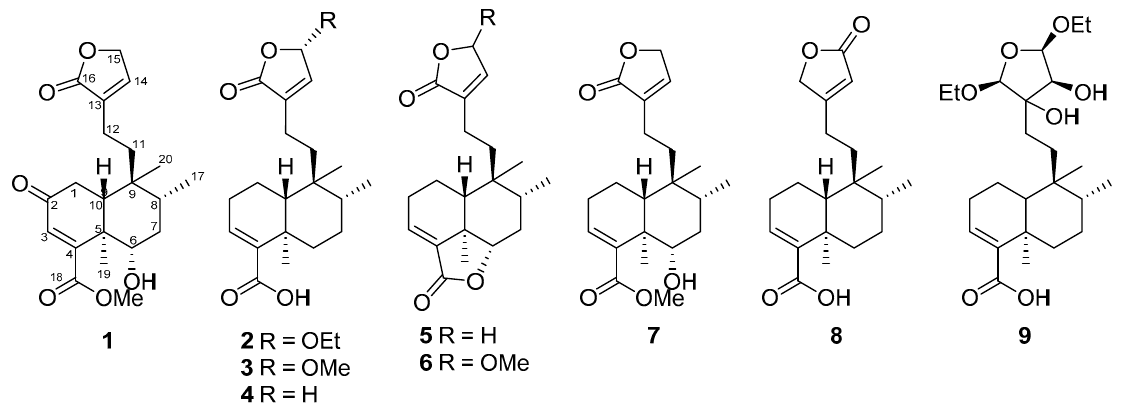
Figure 1 . Structures of compounds 1 – 9 isolated from Callicarpa hypoleucophylla. Figure 1. Structures of compounds 1 – 9 isolated from Callicarpa hypoleucophylla